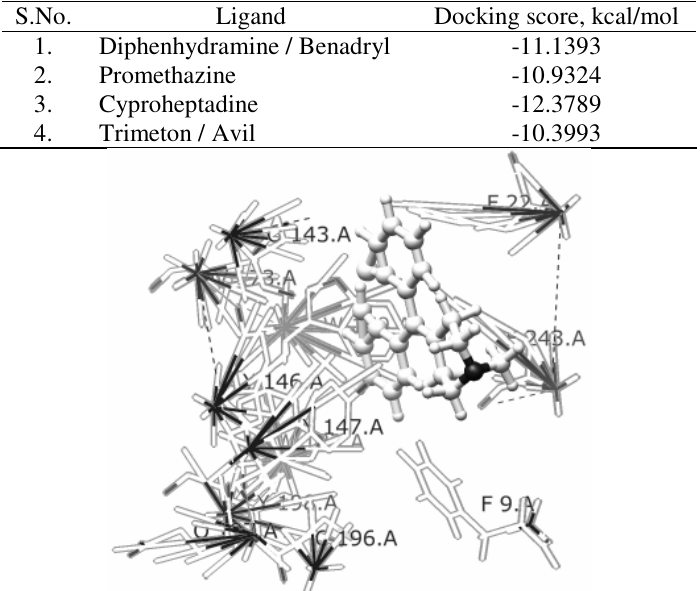
Figure 5. Docked structure of cyproheptadine into the active site of HMT